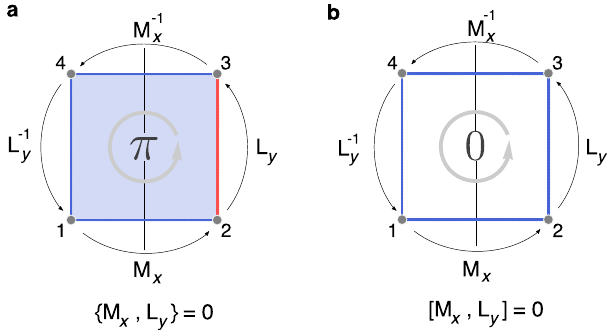
Fig. 1 Flux and symmetry algebra. a A rectangle with π fl ux. Blue/red color indicates hopping amplitudes with positive/negative signs.